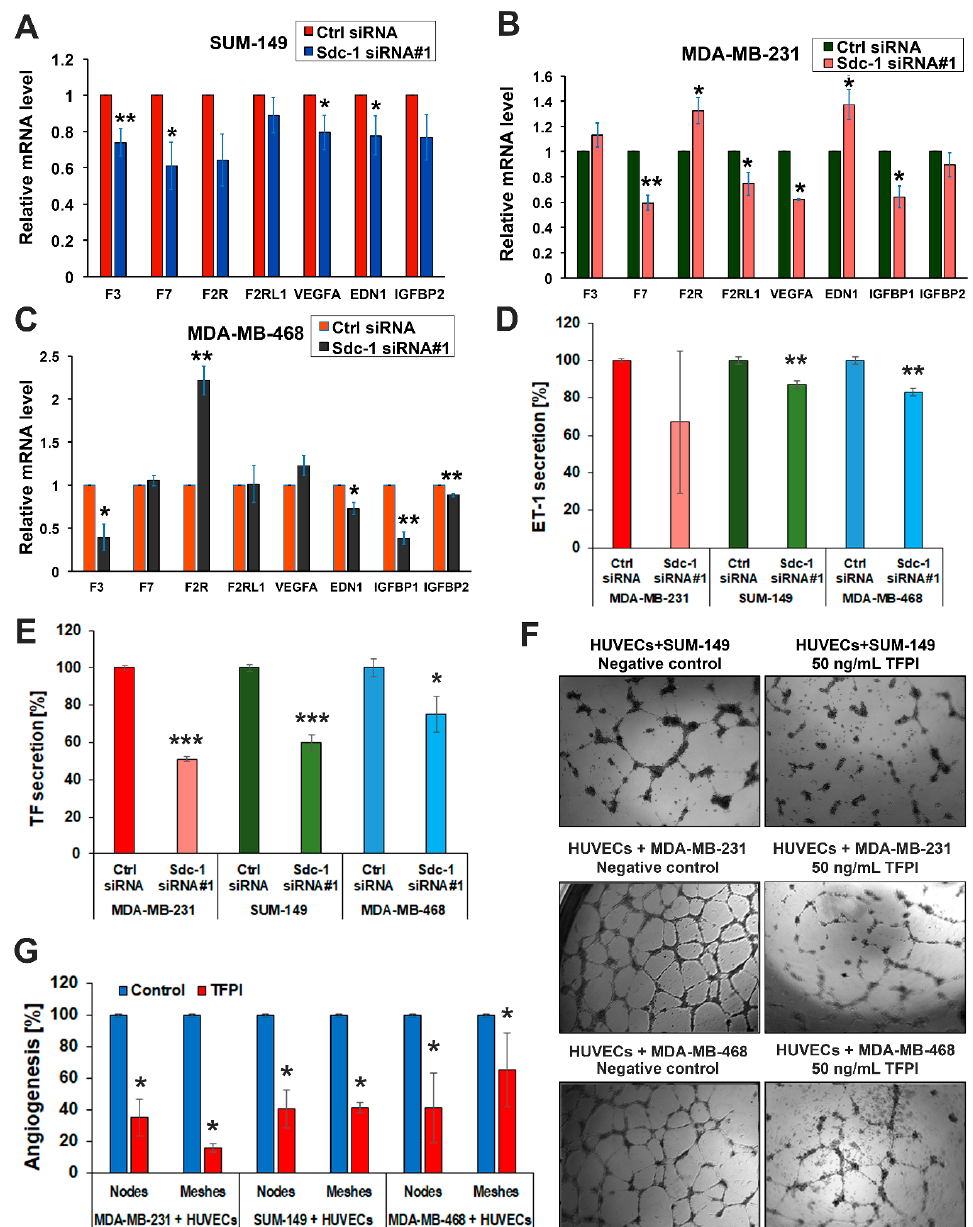
the indicated Sdc-1 siRNA-treated TNBC cells co-cultured in 3D with HUVECs were collected and subjected to profiling. Colored boxes indicate common and cell type-specific dysregulated factors. See Supplementary Figure S2 for densitomet- ric quantification.